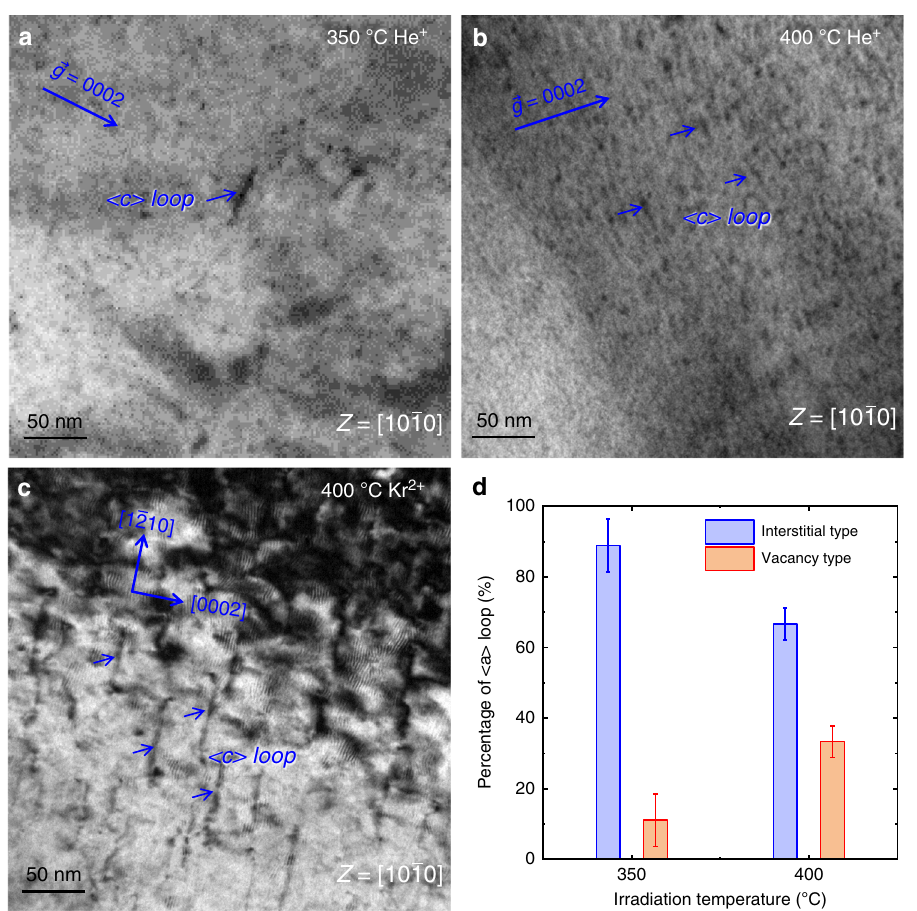
Fig. 2 Dislocation loops in helium and krypton ion irradiated Zr. a Radiation defects formed after helium implantation at 350 °C. b <c> loops produced by helium ions at 400°C. c <c> loops produced by krypton irradiation at 400 °C. d Percentage of <a> interstitial loops and vacancy loops at two irradiation conditions. The statistics involved about 274 loops for 350 °C irradiation and 106 loops for 400°C irradiation. The error bar is added according to the number of uncertain dislocation loops.